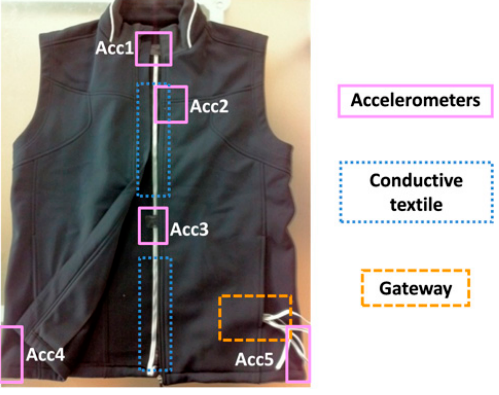
Figure 3. The fully developed wearable instrumented vest.